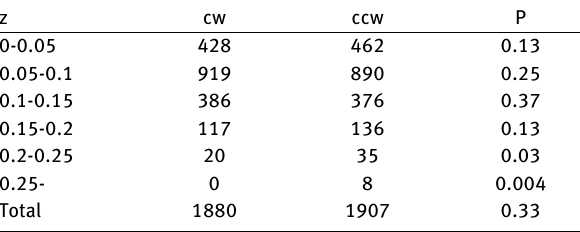
Table 14. The distribution of clockwise and counterclockwise galax- ies in different z ranges in the RA range (< 30 ∘ ∨ > 300 ∘ ).